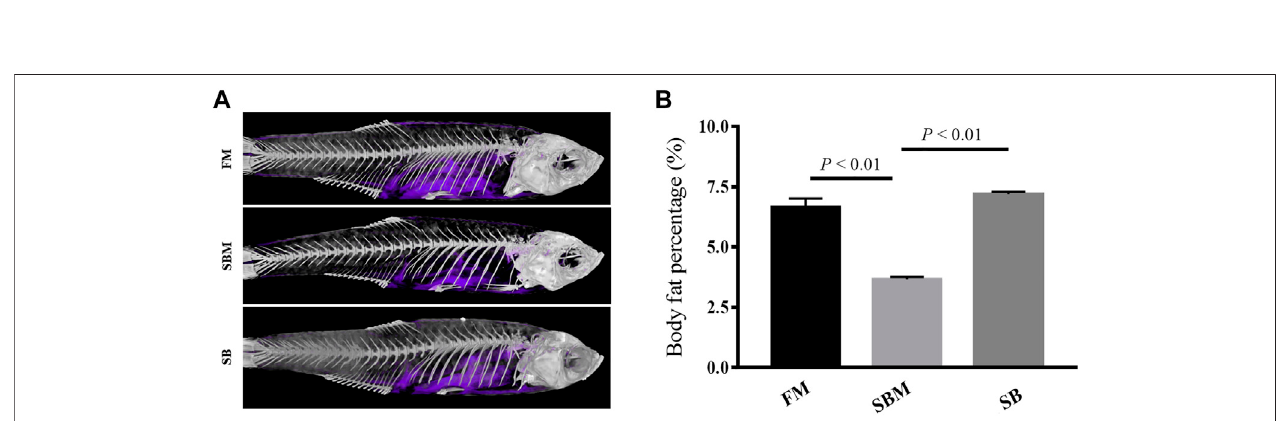
FIGURE 3 | The reconstructed image of body fat revealed by 3D micro-CT in adult zebra fi sh from FM, SBM and SB groups. The body fat in the fi sh trunk was colored purple. (A) The images of body fat (in purple) within the fi sh from all groups; (B) The bar diagram to show percentages of body fat in whole fi sh trunk.